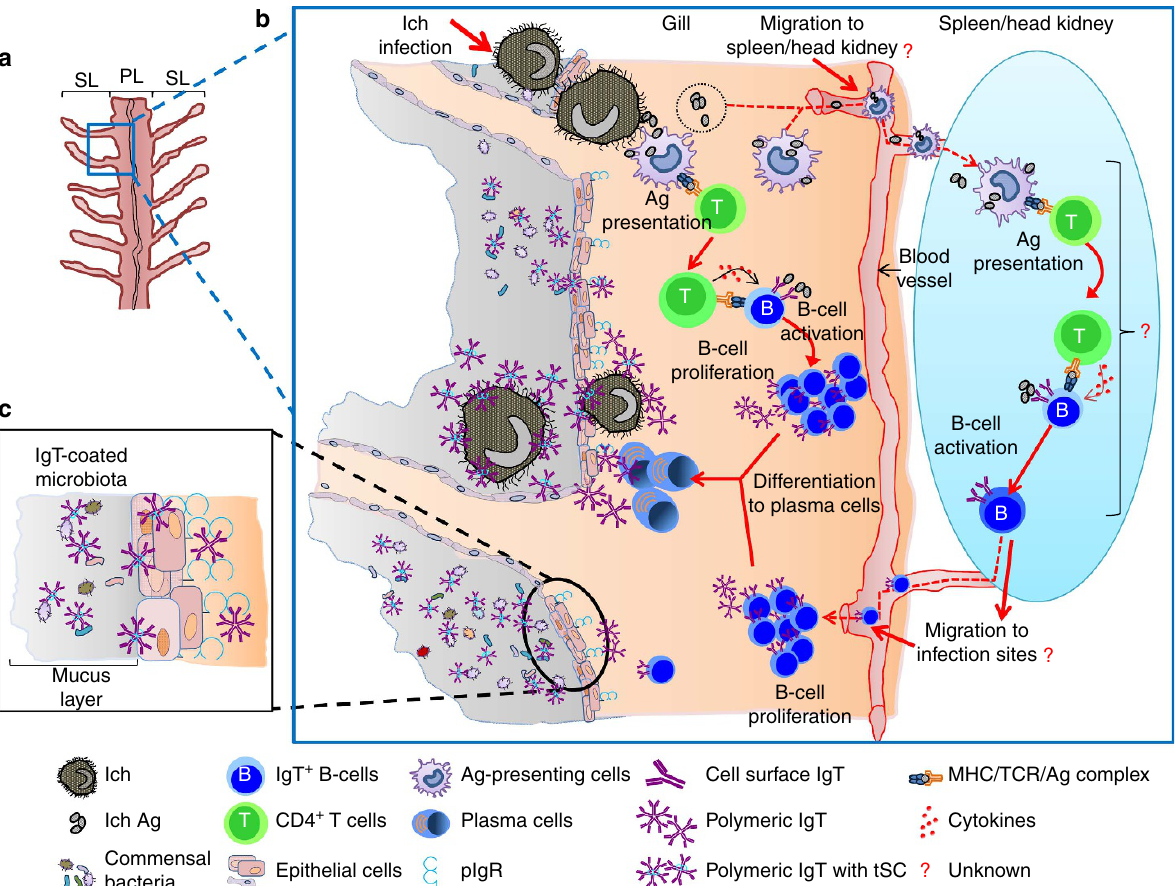
Figure 9 | Proposed model of local IgTand IgT þ B-cell induction in the gills. ( a ) Scheme of a typical teleost gill filament displaying the primary (PL) and secondary (SL) lamellae. ( b ) Induction of local IgTresponses in the gill based on our findings. On Ich infection, Ich antigen (Ag) are taken up by antigen- presenting cells (APC) and presented to naive CD4-Tcells. B cells are then activated by Ag-specific CD4-Tcells and start proliferating. Activated B cells may differentiate further into plasmablasts or plasma cells to produce large amounts of parasite-specific IgT that recognize Ich within the gill PLs or the Ich present in the mucus. We cannot rule out the possibility that on antigen uptake, loaded gill APCs may migrate into central secondary lymphoid organs (that is, spleen or head kidney) where the resulting activated IgT þ B cells may then home into the gill. Alternatively, since gills are highly vascularized, antigens from parasite debris may travel from the gills into the lymphoid tissues through the vascular system, where they could be taken up by systemic APCs to initiate an immune response. In the potential scenarios (as indicated by a ?) where immune responses develop in the spleen or head kidney, we propose that IgT þ B-cell proliferation does not occur in the spleen or head kidney because in Supplementary Fig. 9 we do not detect differences in IgT þ B-cell proliferative responses between control and survivor fish. This would suggest that if activated IgT þ B cells are generated in the spleen or head kidney, then they are probably imprinted to home into the gills where they may then proliferate. ( c ) IgT produced by IgT-secreting B cells is transported from the epithelium into the mucus layer (grey colour) by the tpIgR. The microbiota contained in the mucus is predominantly coated by